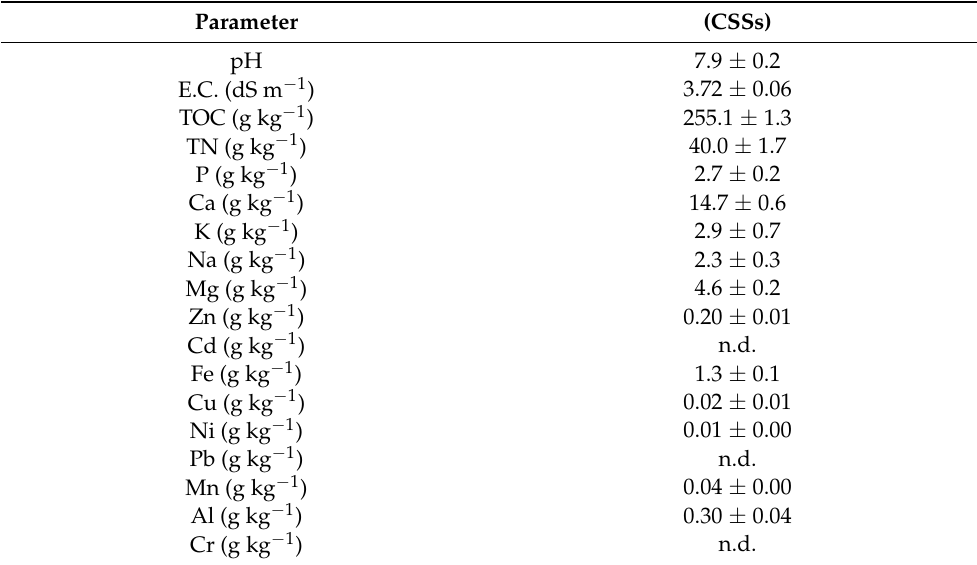
Table 1. Main chemical parameters determined on citrus sewage sludges (CSSs) according to Directive 86/278/ECC [38]. n.d., not detectable.